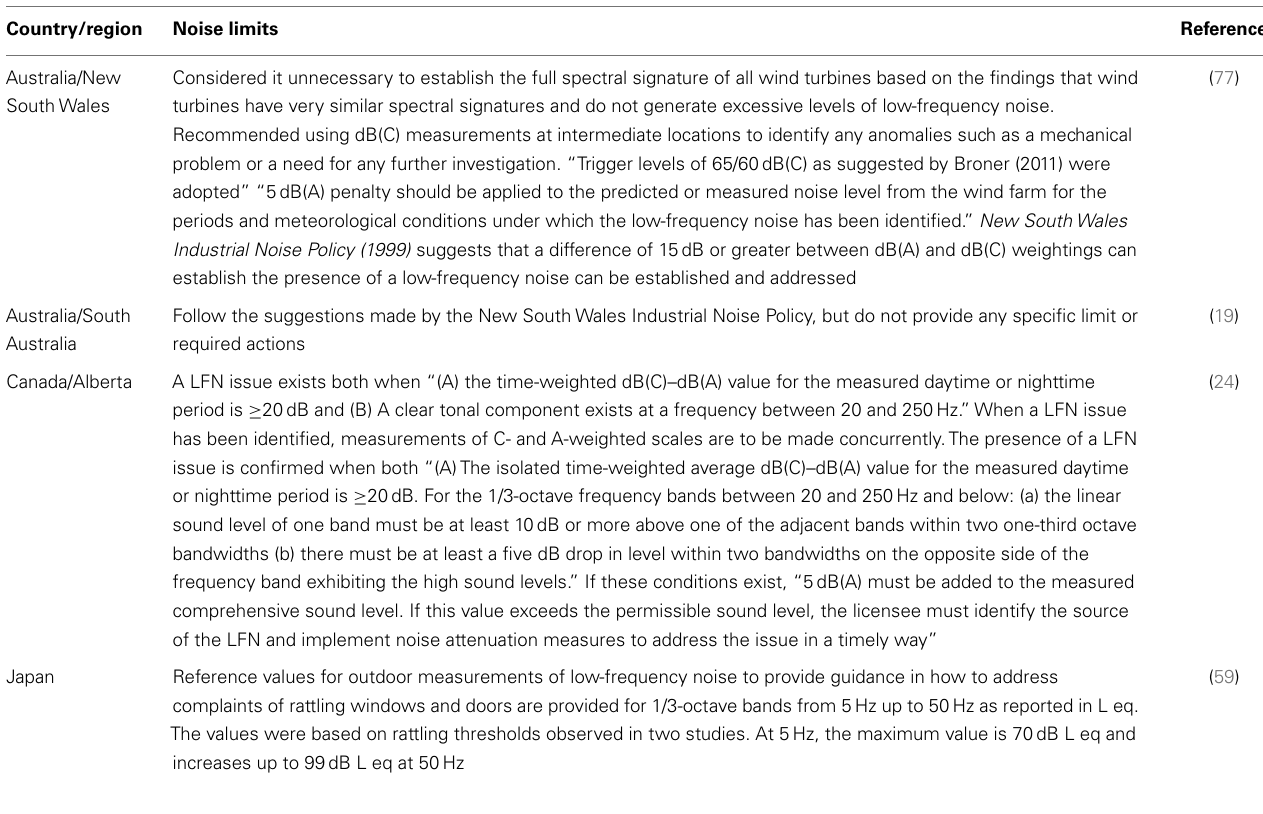
Table 8 | Outdoor LFN noise limits per jurisdiction (not wind turbine specific)